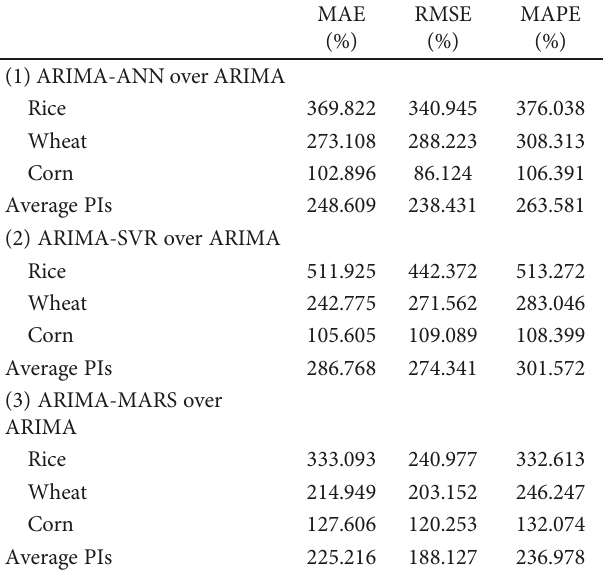
Table 20: PIs of the whole food crop prices by using the proposed integrated models over the single ARIMA models.